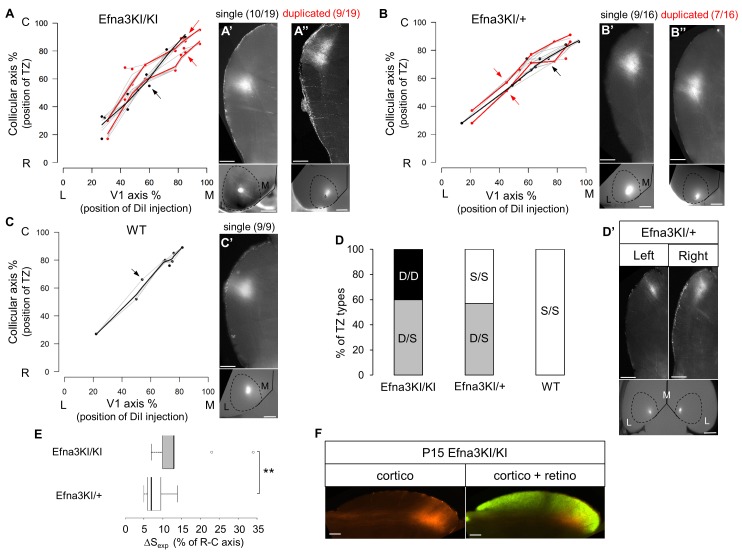
Anterograde cortico-collicular mapping in P14 animals.(A–C) Cortico-collicular maps generated by the Leave-One-Out method at P15 in Efna3KI/KI (n = 19 animals) (A), Efna3KI/+ (n = 16 animals) (B) and WT (n = 9 animals) (C) mutant littermates. Grey lines represent each map for each leave-one-out run for duplicated and single maps. Each dot represent an individual mouse. (A’–C’) show examples of single (A’, B’, C’) and duplicated (A’’, B’’) cortical TZs in collicular sagittal sections from different genotype together with the corresponding injections in V1 (lower panels in A’–C’). The corresponding coordinates are labelled by red arrows (duplicated) or a black arrow (single). Scale bars represent 400 µm (A’–C’), 1 mm (insets in A’–C’). (D–D’) Percentage of heterogeneous duplicated/single (D/S) or homogeneous single/single (S/S) or duplicated/duplicated (D/D) projections in both colliculi of the same animal (D) (Efna3KI/KI, n = 5 animals; Efna3KI/+, n = 7 animals; WT, n = 4 animals). (D’) shows an example of cortico-collicular TZs from left and right colliculi and corresponding V1 injections in a P15 Efna3KI/+ animal. Scale bars represent 400 µm (for colliculi), 1 mm (for V1). (E) Mean separation between duplicated maps measured experimentally (ΔSexp) in Efna3KI/KI (median = 13%, 1stquartile = 10%, third quartile = 13%, n = 9 animals) and Efna3KI/+ (median = 7%, 1stquartile = 6%, third quartile = 9.5 % n = 7 animals) (non-parametric Mann and Whitney test, **p=0.020). (F) Sagittal section of P15 Efna3KI/KI (n = 4 animals) DiI labelled cortical projection (left) and merged image of CTB-488 full-eye fill and cortical DiI projection (right). Scale bars represent 200 µm. L, lateral; M, medial; R, rostral; C, caudal; S, single; D, duplicated; TZ, termination zone; WT, wild-type.